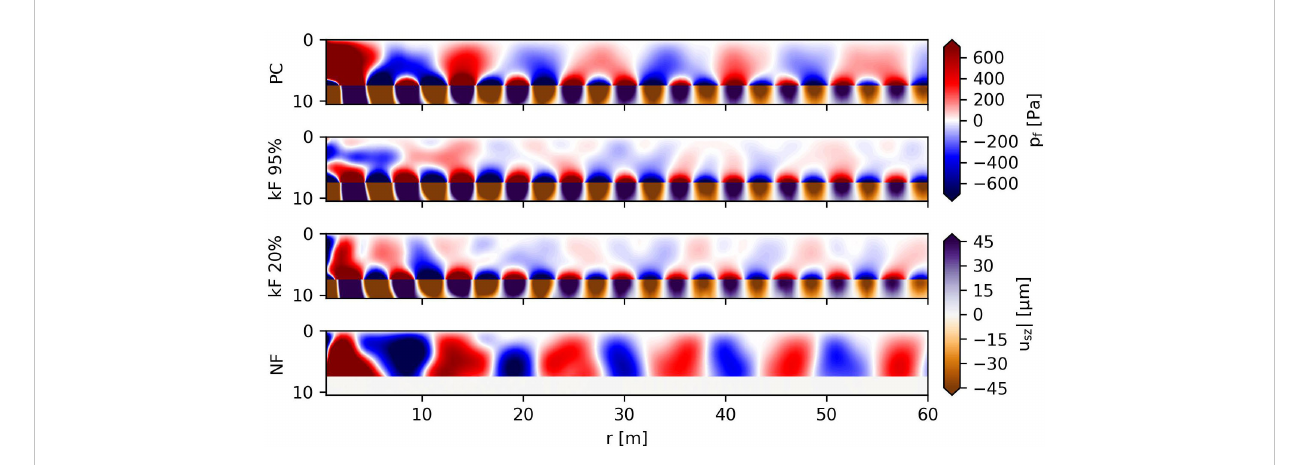
FIGURE 13 Snapshot of time domain pressure fi eld for the periodic force for varying interface conditions with soil with a low shear